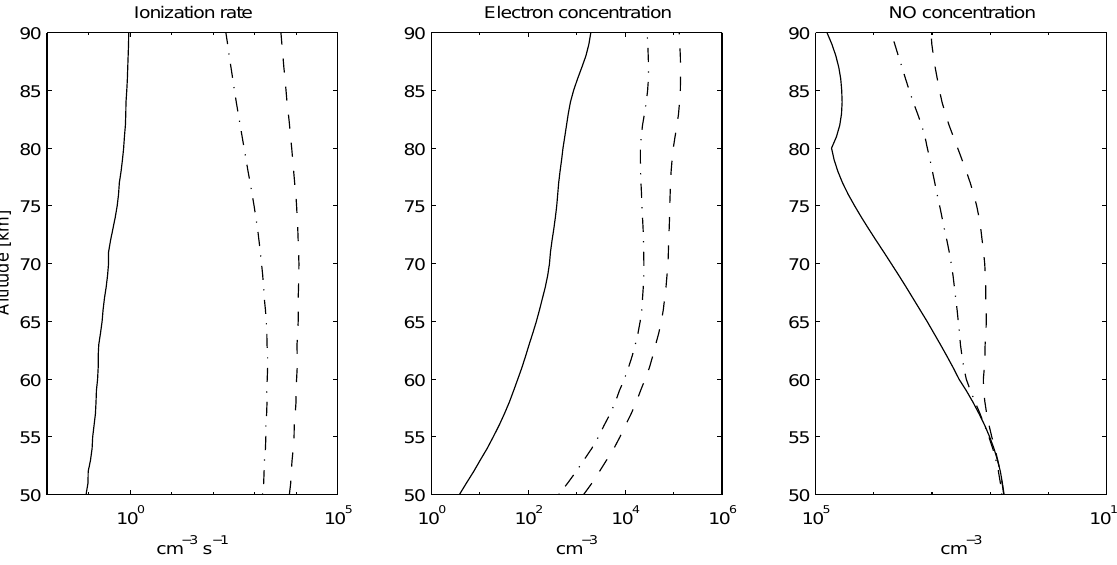
Fig. 2. The modelled ionization rate, electron concentration, and NO concentration profiles during the October 1989 SPE. Solid lines are for the 18, dashed lines for the 20 and dash-dot lines for the 23